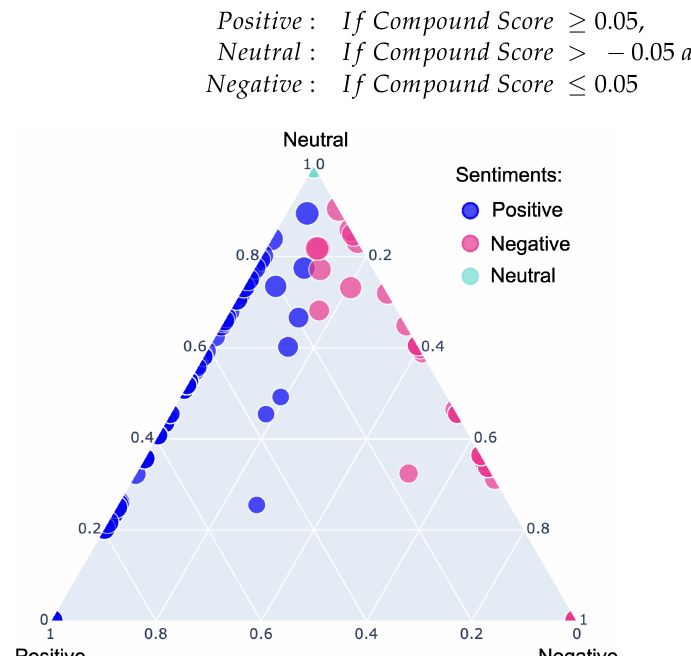
Figure 9. Sentiment classification of surveyees using